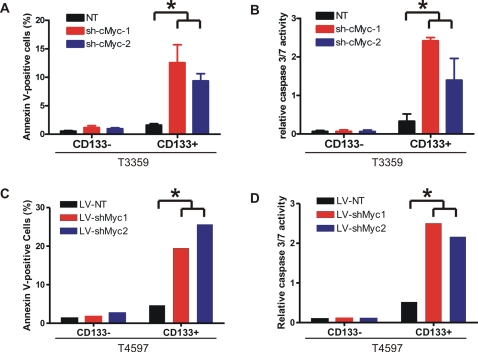
Depletion of c-Myc induces apoptosis in glioma cancer stem cells.(A, B) T3359 and (C, D) T4597 CD133− and CD133+ cells were isolated and infected as described. (A, C) Six days after infection, cells were trypsinized and quantified for apoptosis using the Annexin V-FITC Apoptosis Detection kit (Calbiochem). The percentage of FITC positive cells was determined by FACS analysis, and dead cells were excluded by propidium iodide staining. (B, D) These cells were also plated in 96-well plates at 5000 cells per well for CD133− cells and 1000 cells per well for CD133+ cells after infection and selection. Six days after infection, combined activities of caspase 3 and caspase 7 were determined by the Caspase 3/7 Luminescence Assay kit (Promega), and were normalized by the viable cell numbers determined by the CellTiter-Glo assays as described in Figure 4. *, p<0.05 with one-way ANOVA comparison of the control groups to the corresponding c-Myc knockdown groups.